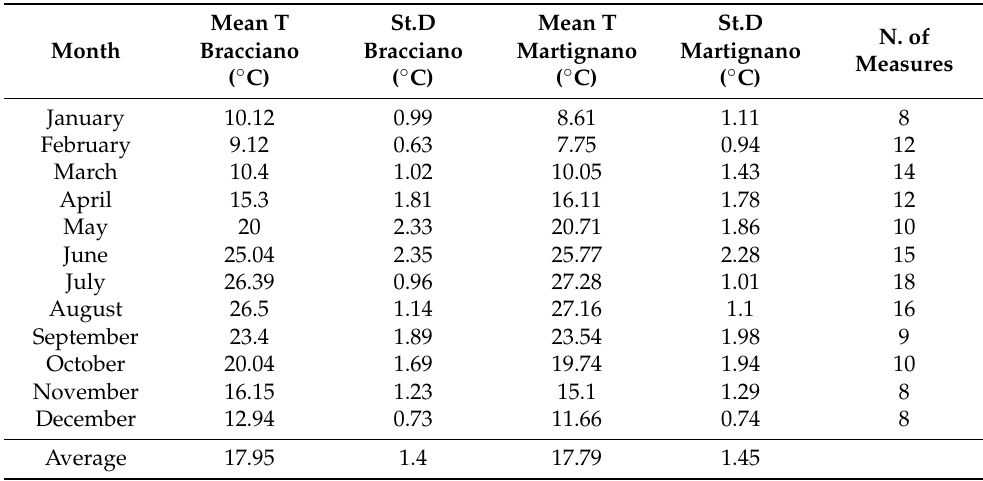
Table 5. Average year derived from Lansdat data acquired from 2000 to 2019 using a standard WST